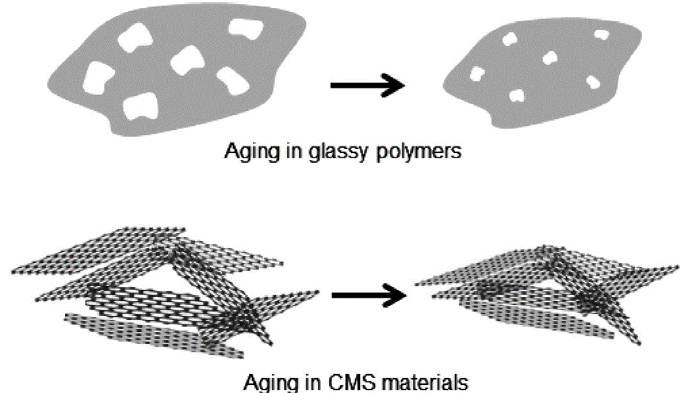
Figure 18. Physical aging of glassy polymers and CMS materials. Adapted from [91] with permission. Copyright (2014) Elsevier.